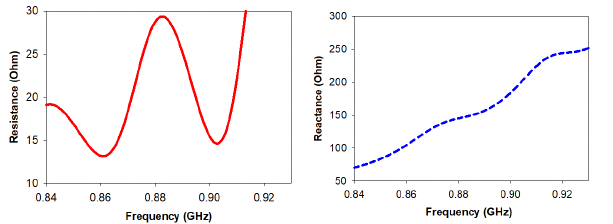
FIGURE 2: Simulated input impedance of the first proposed RFID tag